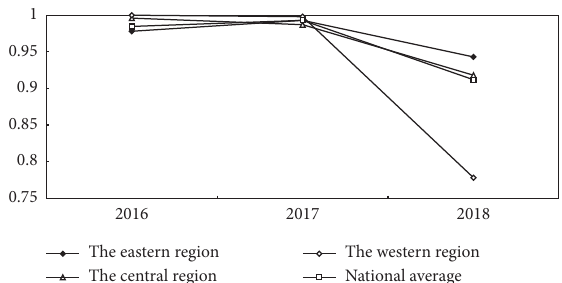
Figure 6: Comprehensive efficiency of green innovation in China’s listed energy companies from 2016 to 2018.